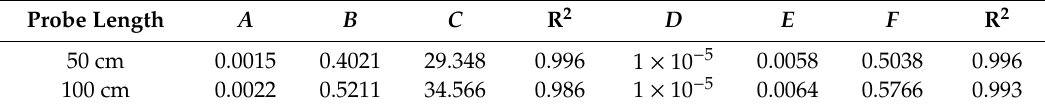
Table 3. Parameters of dielectric constant and SWC estimated from calibration results for HETDR. Probe length